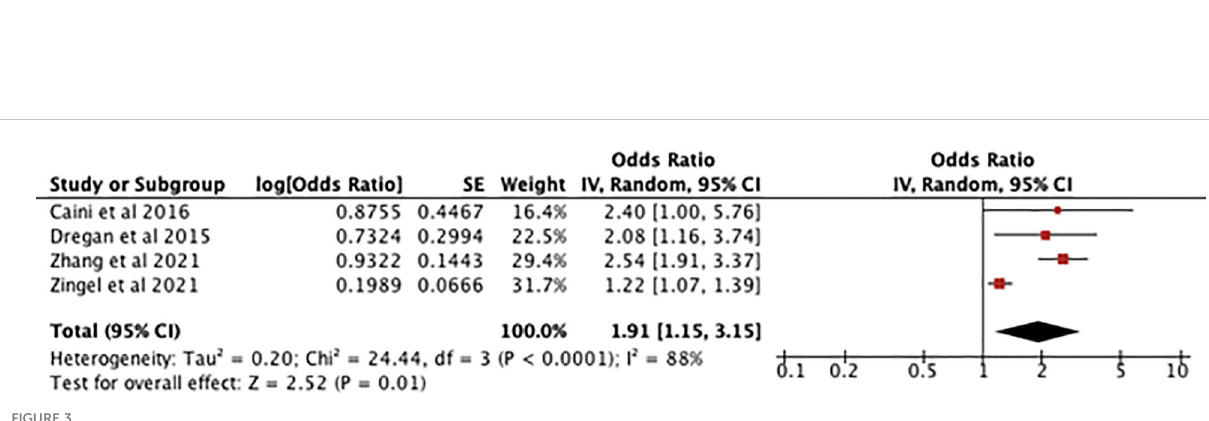
FIGURE 3 forest plot showing the results of the meta-analysis exploring the relationship between IBD and risk of dementia. Positive values indicate that dementia and cognitive decline are more prevalent in IBD patients, with the P value showing its statistical signi fi cance (7 – 10).